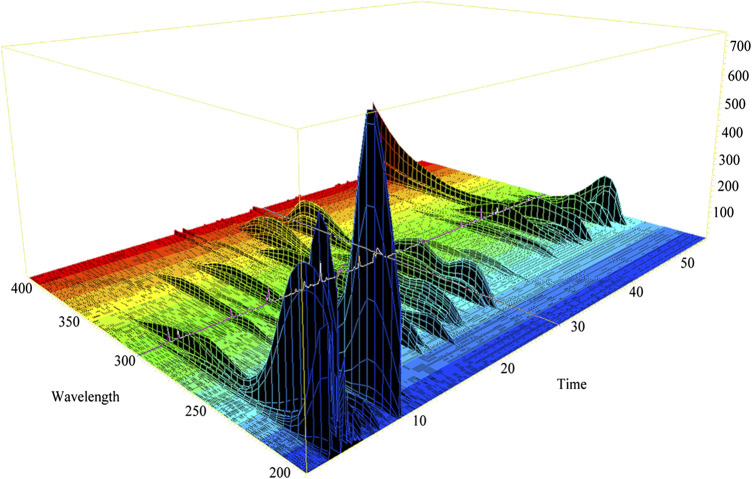
The 3D-HPLC chromatogram of GDD.